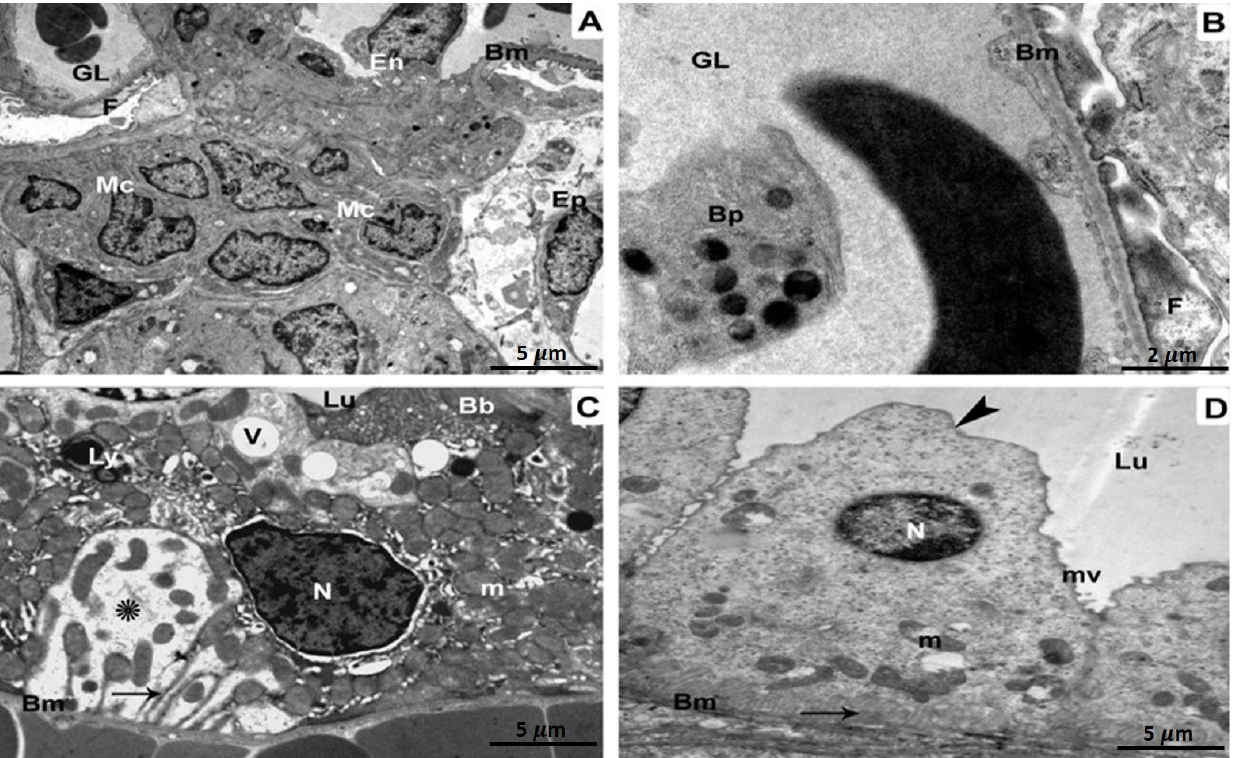
Figure 3. TEM investigation of kidney specimens of BPA-treated group. ( A ) The basement membrane (Bm) as well as glomerular capillaries of a pleomorphic glomerulus, are wrinkled and branching (GL). Podocytes, in addition to mesangial cells (MCs) proliferate, and the endothelium (En) is injured5 µm scale bar; ( B ) A more powerful magnification is displaying glomerular basement membranes (Bm) with fusion foot processes (F) and some blood platelets (Bp) within the glomerular lumen (GL) 2 µm scale bar; ( C ) Abnormal aggregation of lysosomes (Ly) as well as vacuoles (V) in the Epithelium of a distorted proximal tubule (Ep). Brush borders (Bb), pyknotic nuclei (N), enlarged mitochondria (m), lipid droplets (L), and also the tubular basement membrane (BM) are all disrupted (Bm). There is evidence of both damaged cytoplasm (shown by the star) and infolding membranes (represented by the arrow). Magnification: 5 µm scale bar ( D ) A districted epithelium (Ep) organelles lying on the basement membrane in the lumen (Lu) of a disrupted distal tubule with an enlarged apical region of Epithelium (arrowhead) (Bm). Vacuoles (V), dysfunctional mitochondria (m), as well as deteriorated nuclei (N) are also observable. At 5 µm scale bar, we can clearly detect disrupted cytoplasm (star) as well as infolding membranes (arrow).